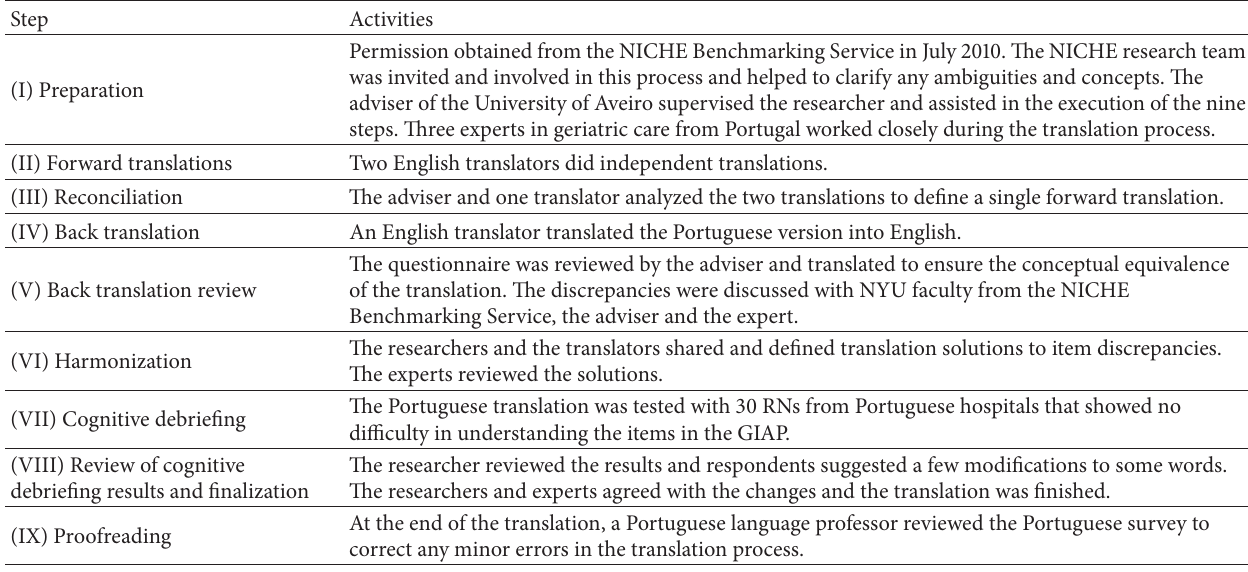
Table 1: Steps in translation and cultural